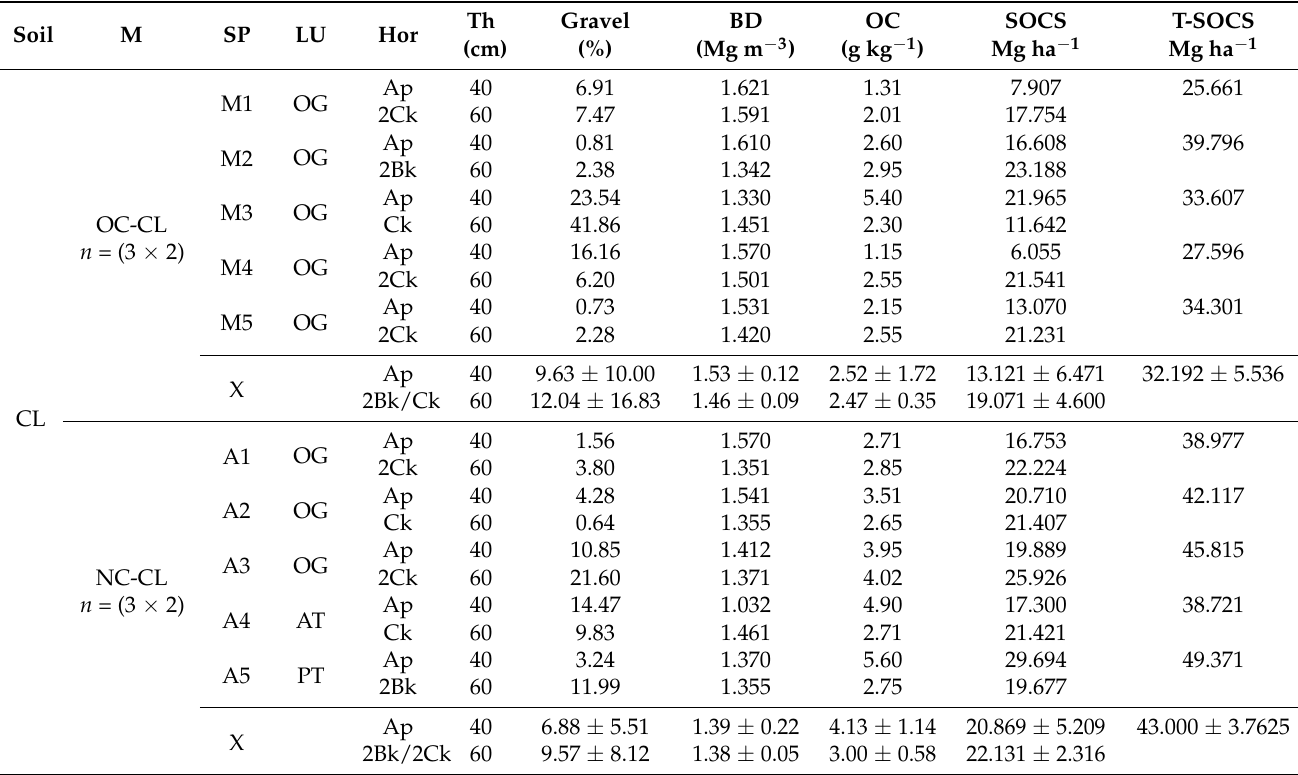
Table 7. Soil organic carbon stock in